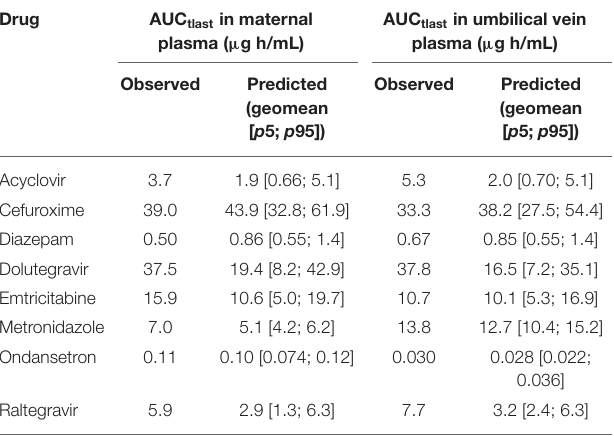
TABLE 6 | Observed and predicted drug exposure in mother and fetus. Drug AUC tlast in maternal AUC tlast in umbilical vein plasma ( µ g h/mL) plasma ( µ g